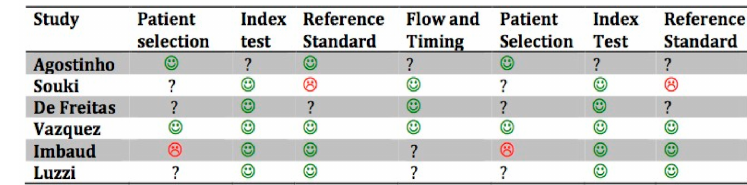
Figure 2. Quality assessment of included studies based on QUADAS-2. The figures in green indicate a low risk of bias: The figures in red indicate a high risk of bias. The question marks indicate that the risk of bias in